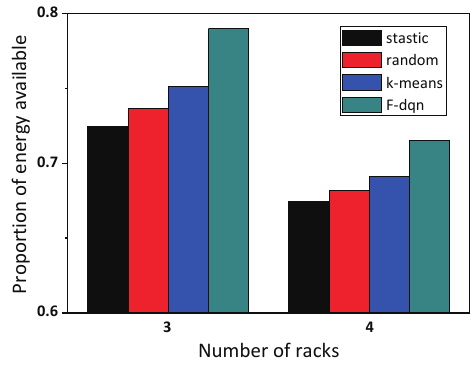
Figure 8. The Comparison of Proportion of Power